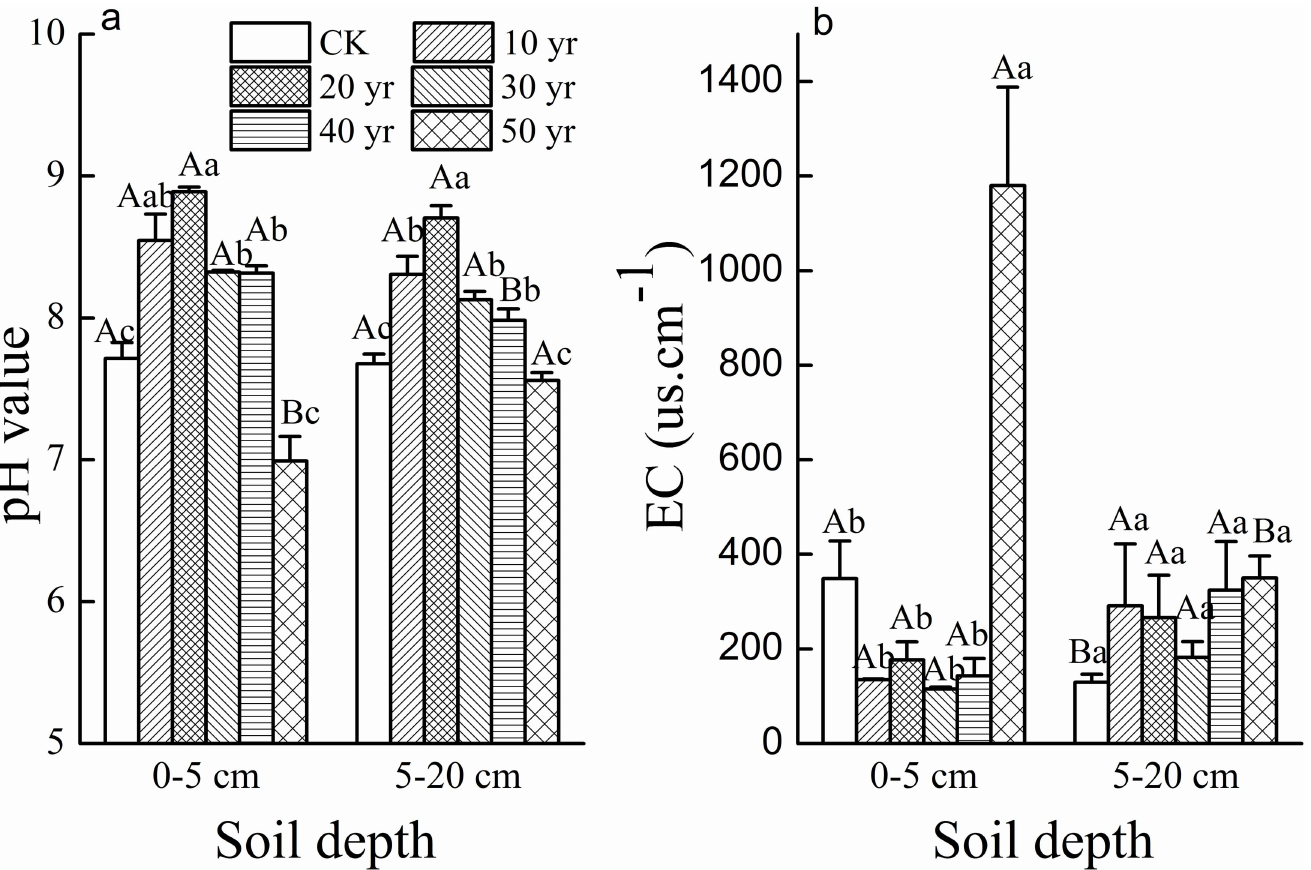
Fig 5. Soil pH value (a) and electrical conductivity (EC us.cm -1 ) (b) (mean ± SE)in the 0-5cm and 5-20cmsoil layers of H . ammodendron plantations planted in different decades across 50 years (CK-mobile sand dune). (Different uppercase letters indicatesignificantdifferences in soil